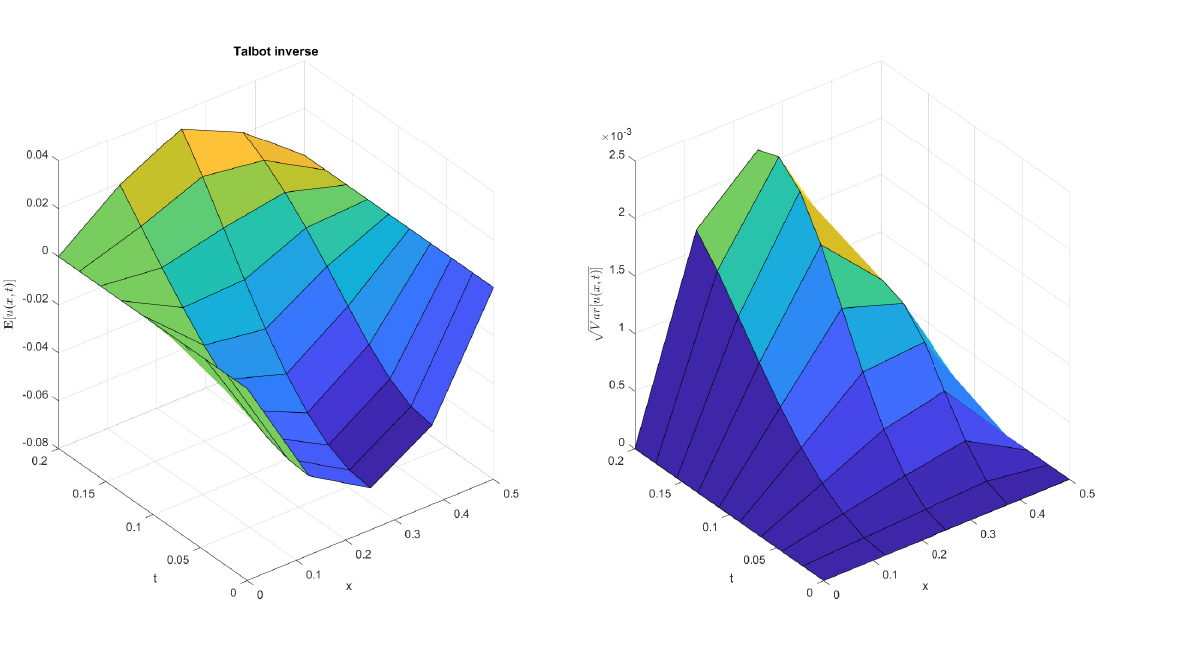
= 10 3 simulations. MC